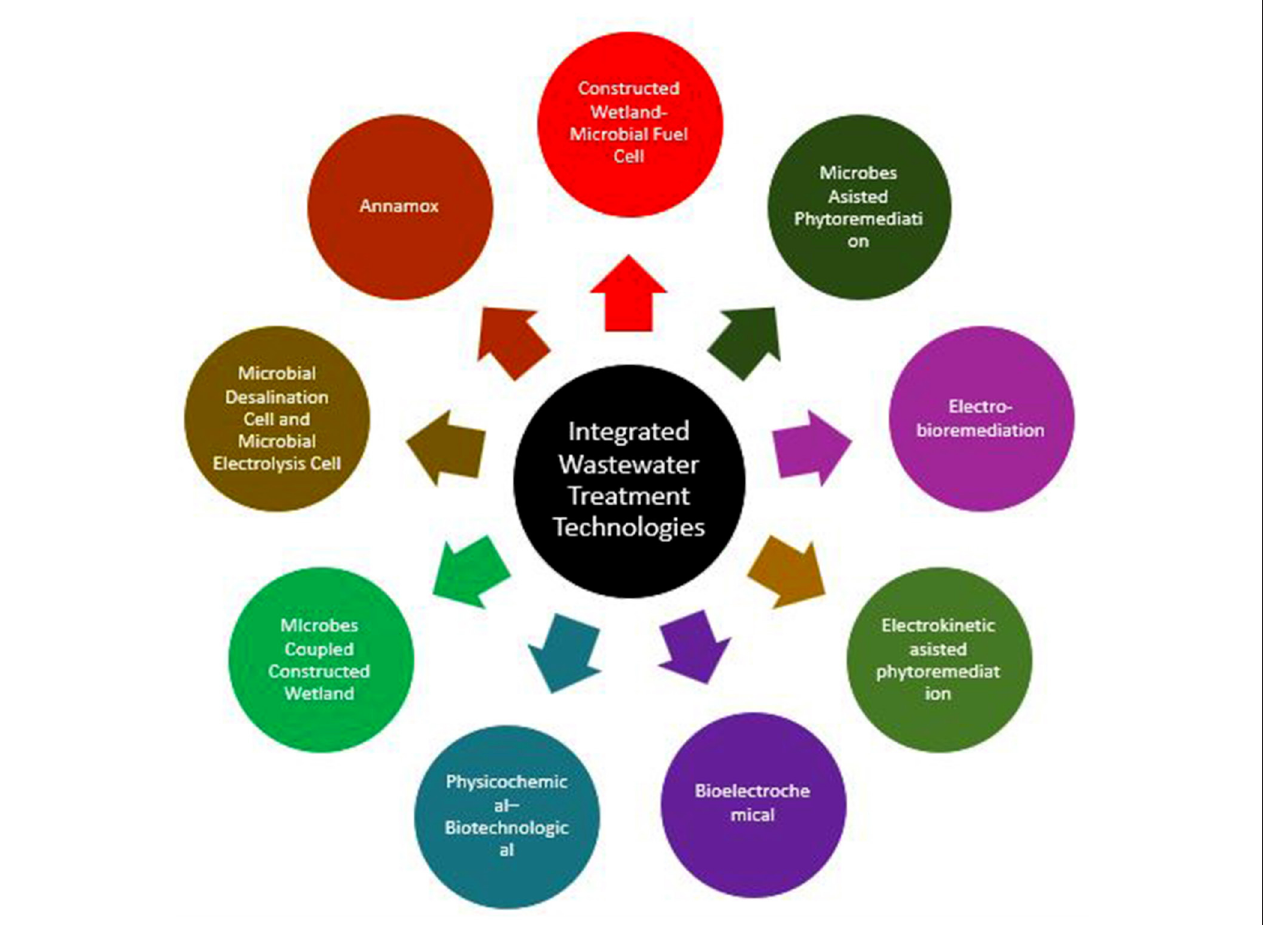
FIGURE 1 | Various integrated environmental technology used for wastewater treatment and management.